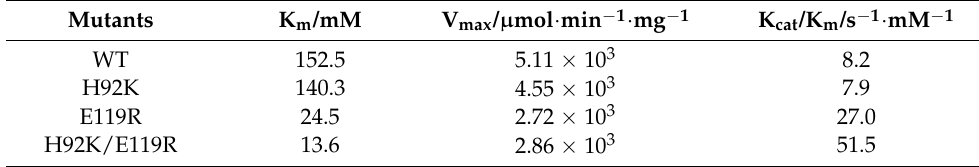
Table 1. K m , V max , and K cat /K m of WT and mutants on mannose.